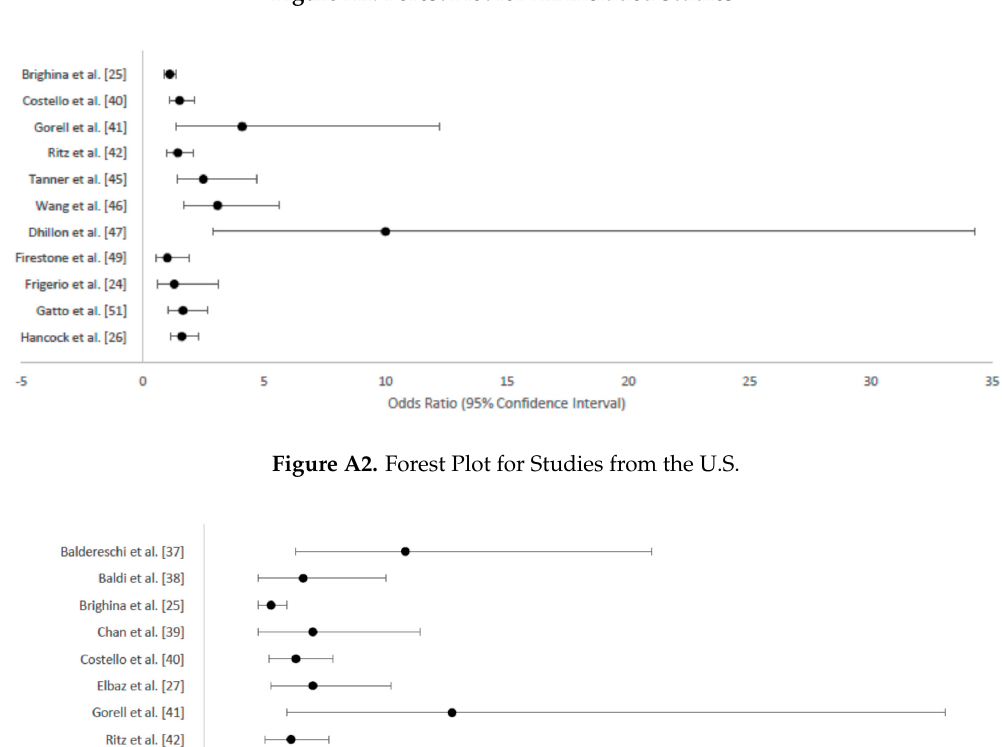
Figure A1. Forest Plot for All Included Studies.